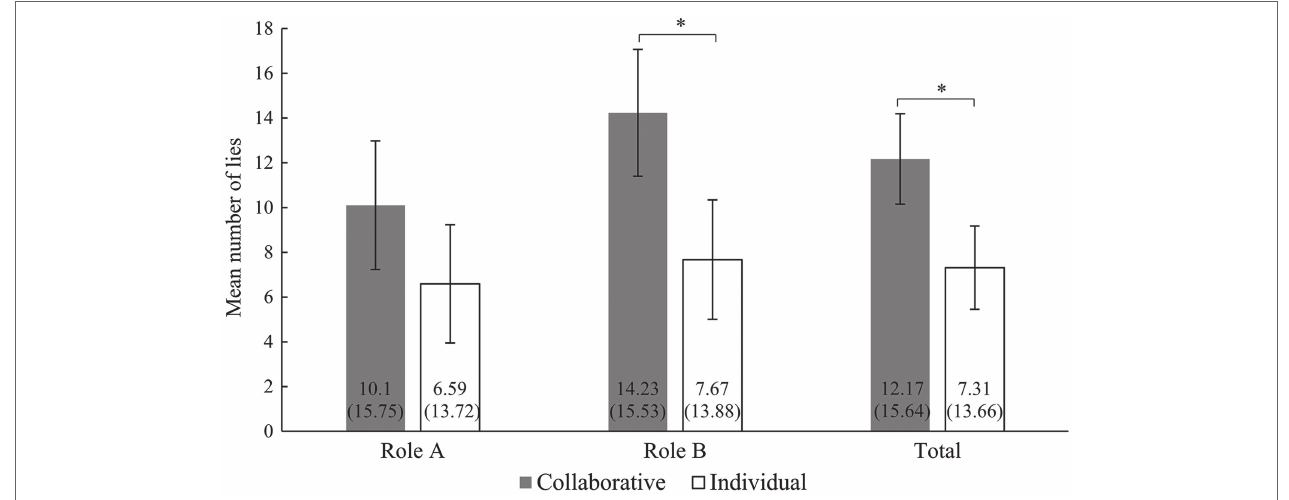
FIGURE 4 | The mean number of lies for different roles in the two conditions. Error bars are ±1 SE; mean and SD are at the bottom of each bar; significance indicators: * p <